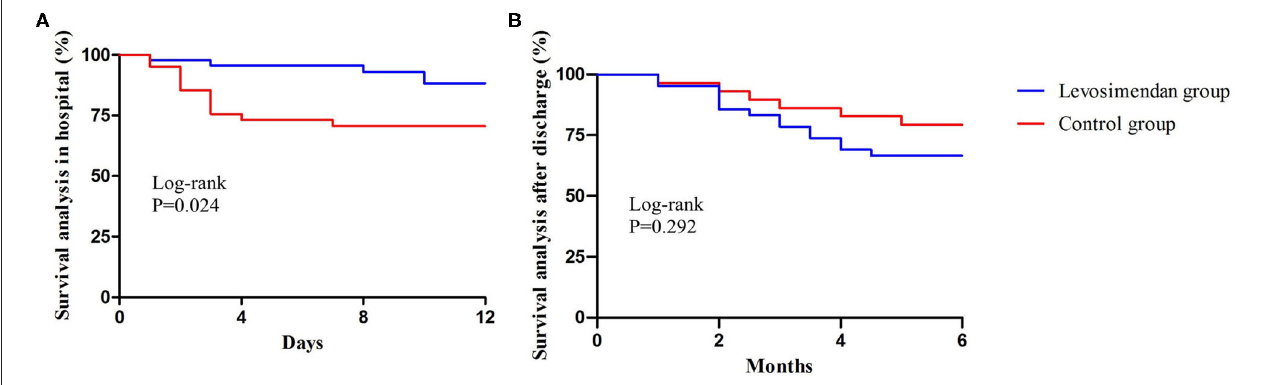
FIGURE 4 | Survival analysis between two groups in hospital (A) and after discharge (B)